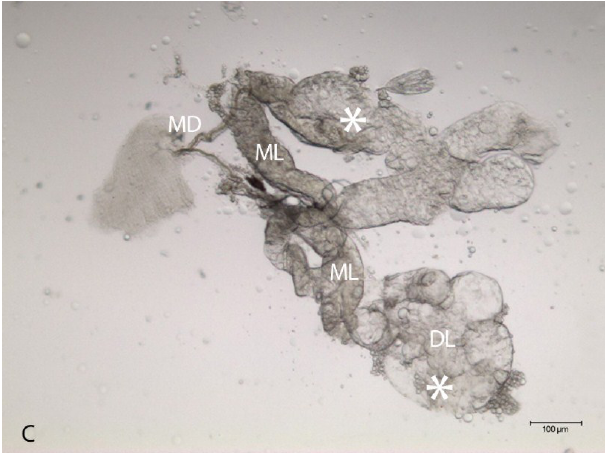
Figure 1. SINV-associated pathology in SG’s dissected from adult female Ae. aegypti mosquitoes. ( A ) Bright field image of a SG from an uninfected mosquito. The lateral lobes (LL), proximal lateral lobe (PL), distal lateral lobe (DL), neck region (NR) separating PL from DL and median lobe (ML) are labeled for orientation purposes; ( B ) Bright field image of a SG dissected at 14 days p.i. with AR339 per os . The DL and PL appeared grossly cytopathic ( * ), one LL was completely disrupted and absent, while the ML remained intact; ( C ) Bright field image of a SG dissected at 28 days p.i. with TR339 per os . Two sets of SG’s are displayed, connected by the two main ducts (MD), some CPE ( * ) is observed in the DL, while the two ML appear